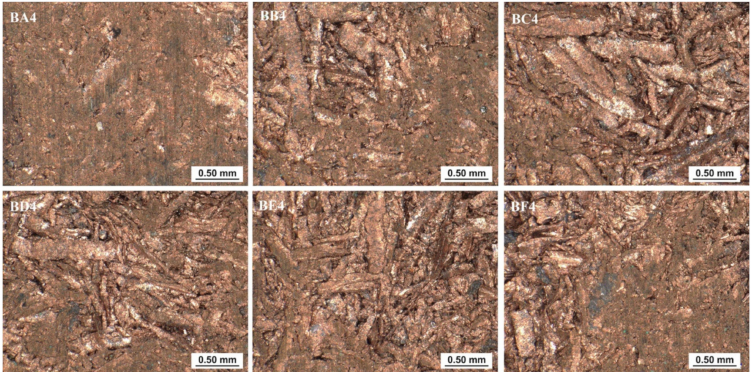
Figure 21. Pictures of the selected areas of the back surface of the briquette.